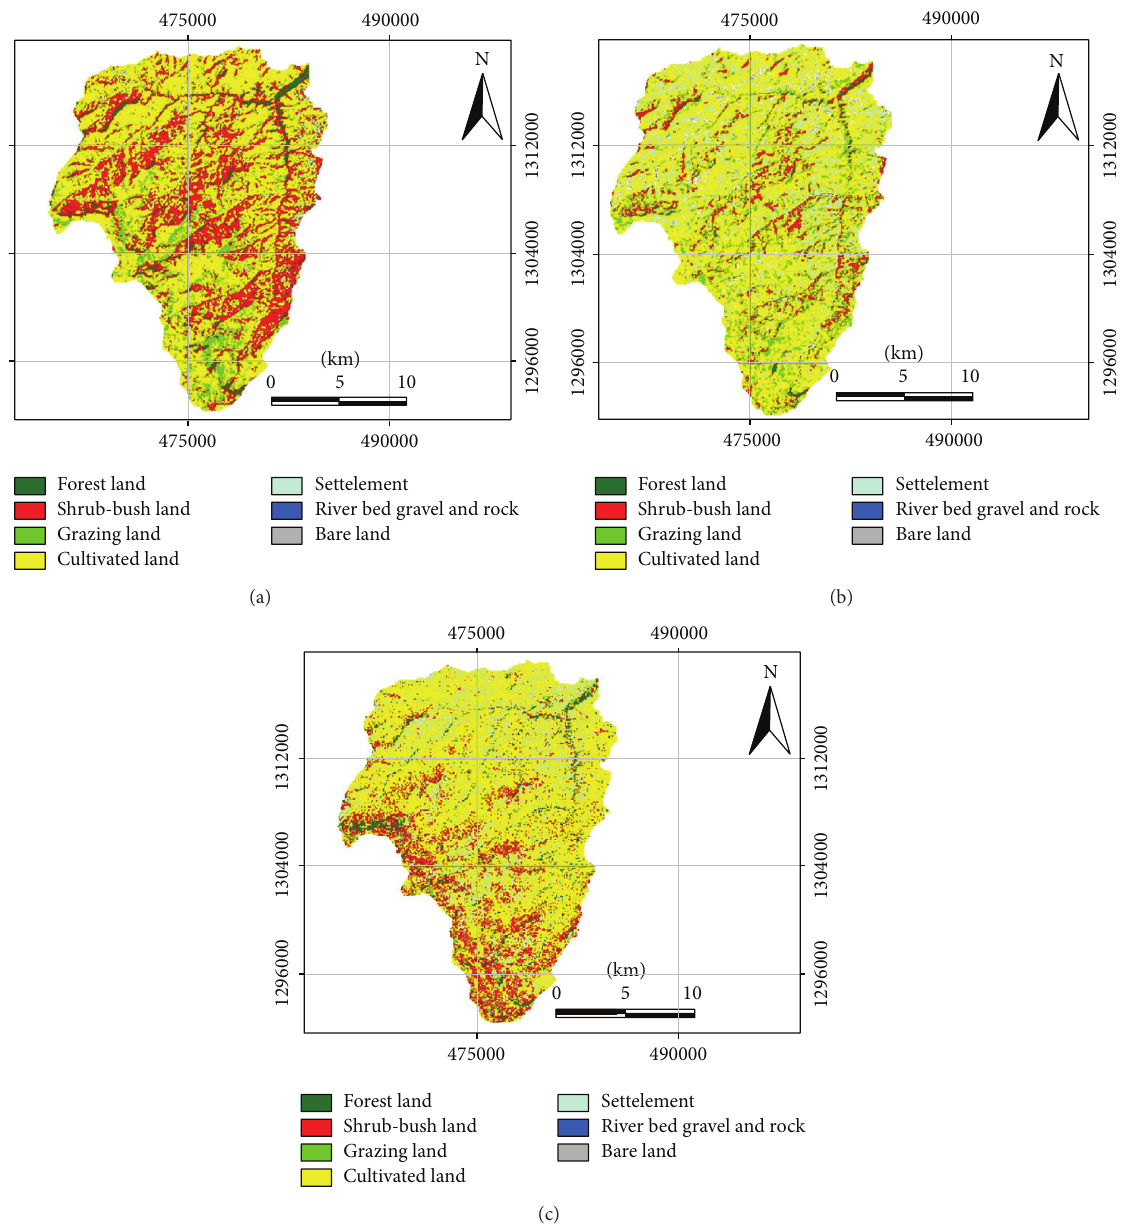
Figure 2: Land use and land cover maps of Gilgel Tekeze catchment for the years 1976 (a), 1986 (b), and 2008 (c).